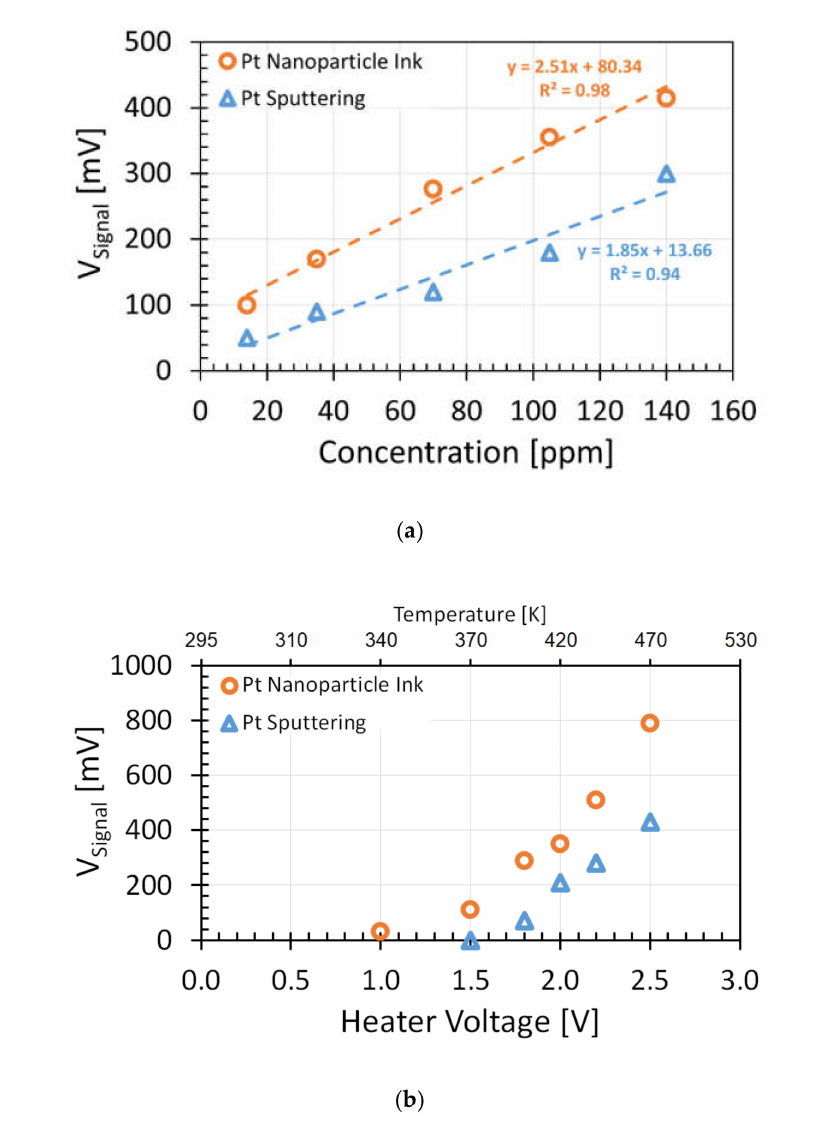
Figure 7. Experiment results for ethanol detection over Pt nanoparticle layer and sputtered Pt thin film layer: ( a ) Voltage signal as function of ethanol concentration at constant heater voltage of 2 V; ( b ) voltage output signal as a function of heater voltage applied to heating resistor at constant temperature and at constant concentration of 100 ppm of ethanol. Voltage output signal with 5.2 dB